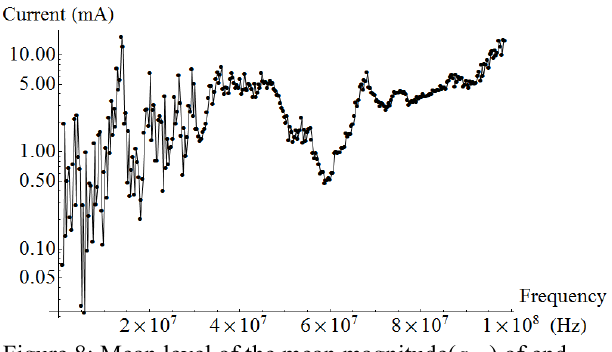
Figure 8: Mean level of the mean magnitude( a current |I out